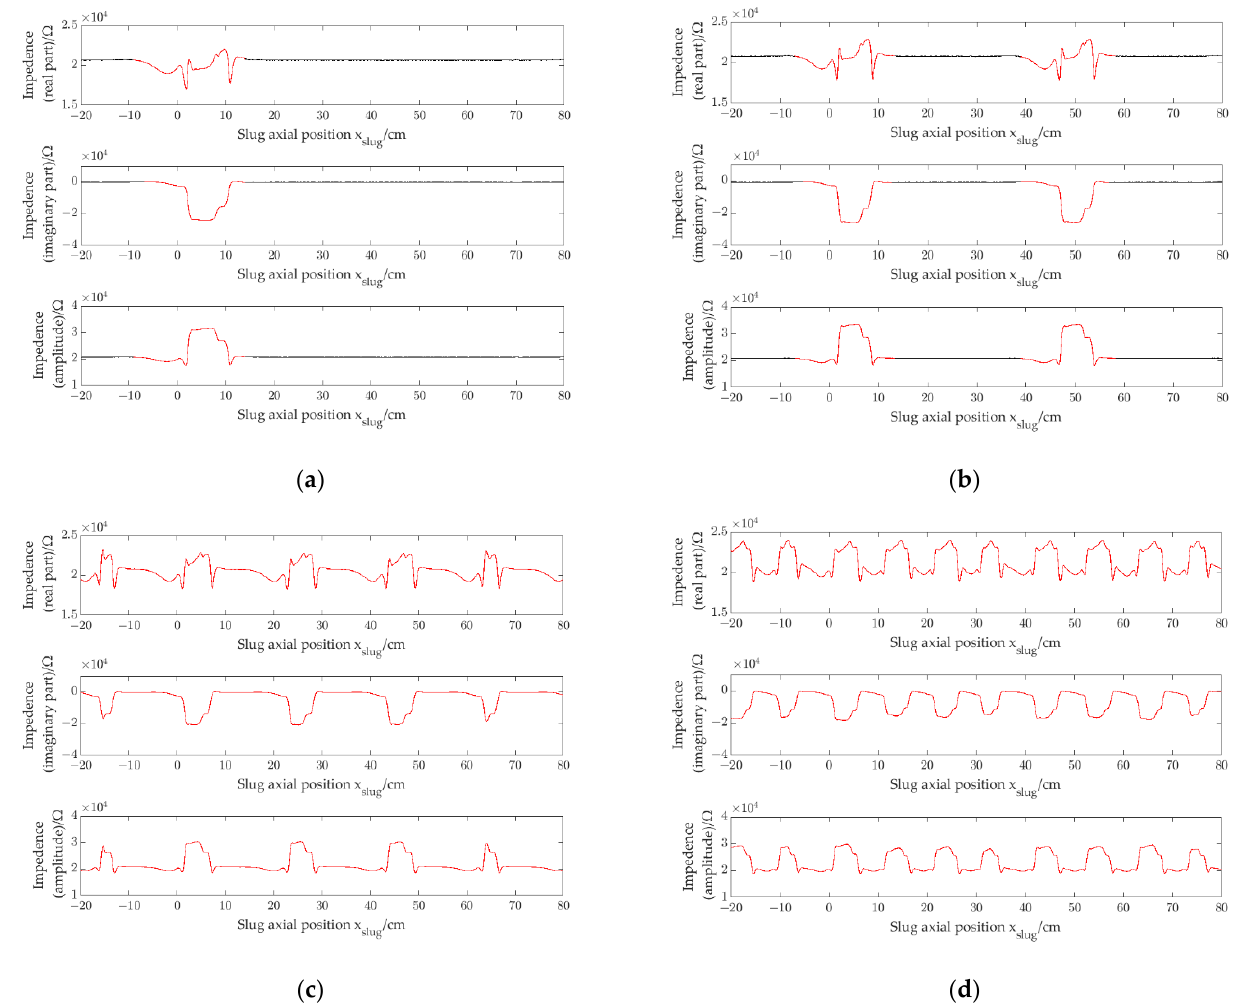
Figure 10. Impedance signals of slug flow, i.d. = 1.96 mm: ( a ) single slug; ( b ) signal separation distance is 44 cm ( ρ re = 0.88, ρ im = 0.99 and ρ am = 0.88); ( c ) signal separation distance is 22 cm ( ρ re = 0.94, ρ im = 0.99 and ρ am = 0.94); ( d ) signal separation distance is 11 cm ( ρ re = 0.30, ρ im = 0.49 and ρ am =